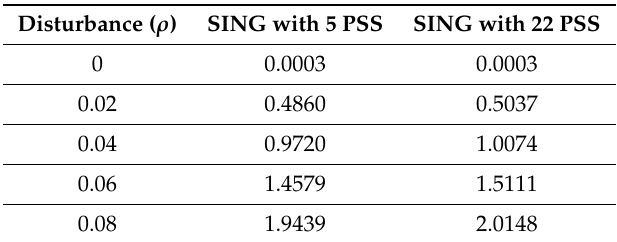
Table 8. Cost of energy loss under permanent regime for each machine (in 10,000 dollars per